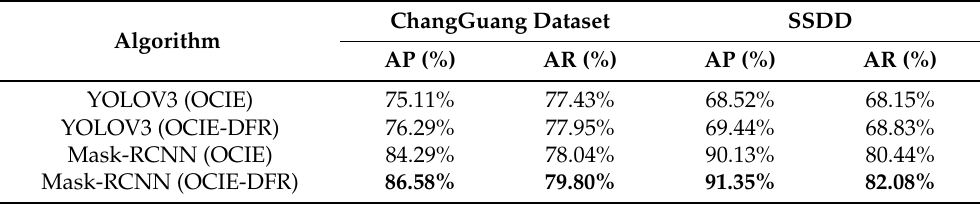
Table 2. Experimental results of the DFR module on the ChangGuang dataset and